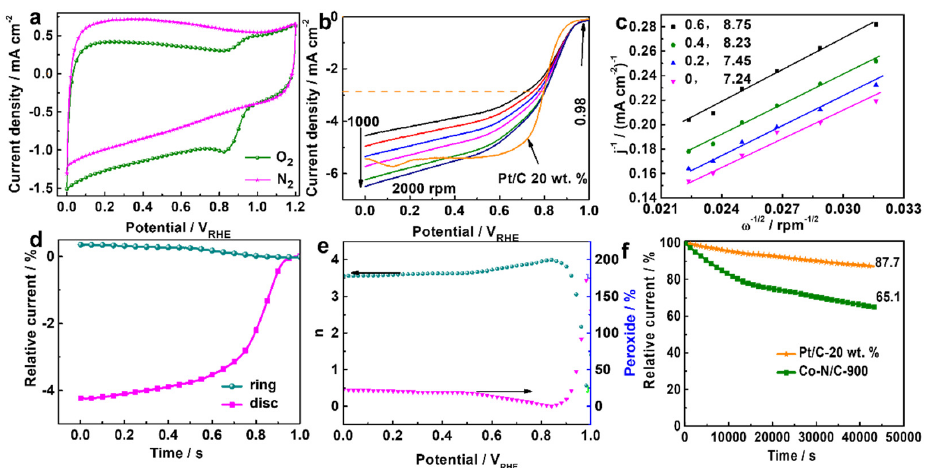
Figure 5. ( a ) CV on Co/N-C-900 in N 2 , O 2 -saturated electrolyte of 0.1M KOH solution, ( b ) LSV for Co/N-C-900 and Pt/C at 1600 rpm, ( c ) K-L lines. ( d ) LSV of the RRDE measurements (1600 rpm) of Co/N-C-900 ( e ) n and H 2 O 2 % at different potentials, ( f ) current–time curve 0.755 V RHE of Co/N-C- 900 for ORR.